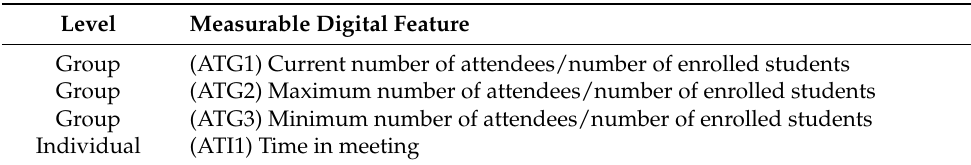
Table 7. Set of digital features defined for “Attendance” category, corresponding to features B17 and E13.